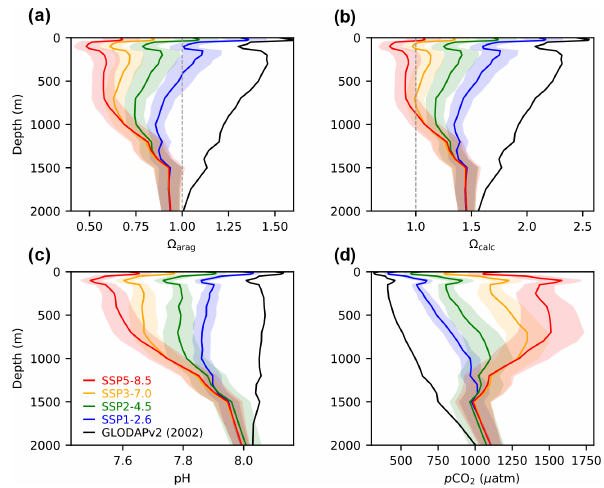
Figure 4. Vertical profile of basin-wide Arctic Ocean calcium car- bonate saturation states, pH, and p CO 2 in 2100. Multi-model mean vertical profiles of (a) aragonite and (b) calcite saturation states, (c) pH, and (d) p CO 2 in 2100 for SSP1-2.6 (blue), SSP2-4.5 (green), SSP3-7.0 (orange), and SSP5-8.5 (red) averaged (a) with ± 1SD ( n = 12–14) shown as a shaded area. Observed profiles in 2002 from GLODAPv2 are shown in black (Lauvset et al., 2016).